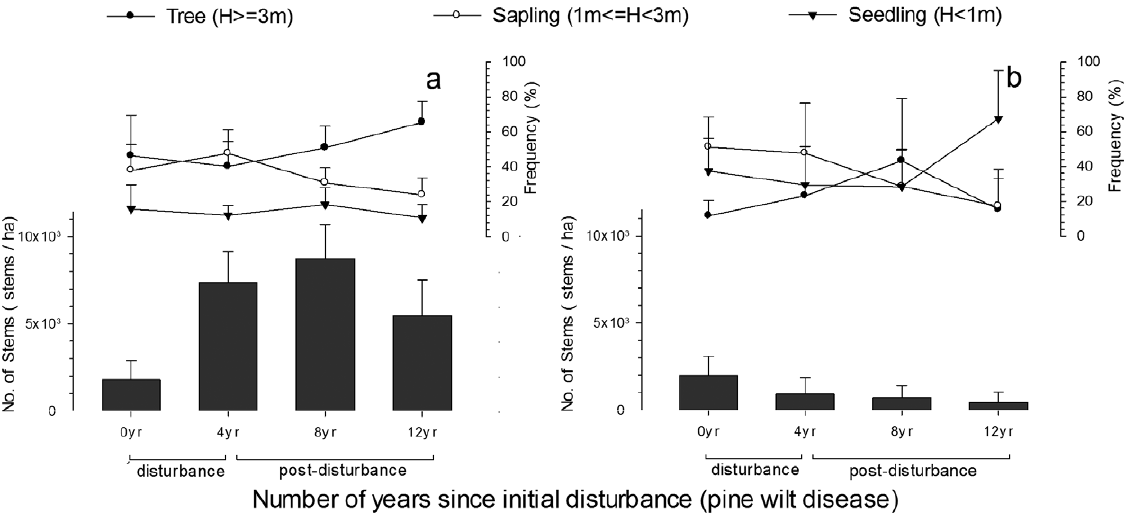
Figure 4. Stem density and life stage structure of PFT1 (a) and PFT2 (b) after pine wilt disease. doi:10.1371/journal.pone.0036432.g004 PLoS ONE |